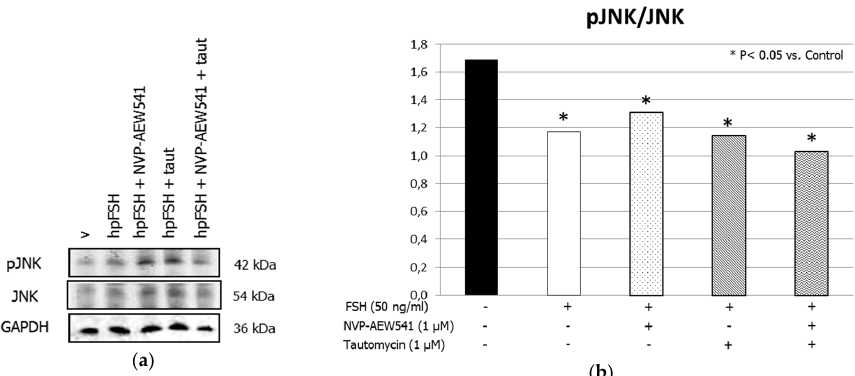
Figure 4. IGF1R does not influence the FSH-induced JNK (Thr18/Tyr185, Thr221/Tyr223) dephosphorylation. ( a ) Immunoblots and ( b ) densitometric analysis of the protein bands of pJNK, JNK and GADPH from SCs alone (control), or incubated with hpFSH alone or pre-treated with the IGF1R inhibitor NVP-AEW541 and/or PP1ß inhibitor tautomycin and then incubated with hpFSH. Data represent the mean ± SEM (* p < 0.05 vs. control) (one-way ANOVA) of three independent experiments, each performed in triplicate.